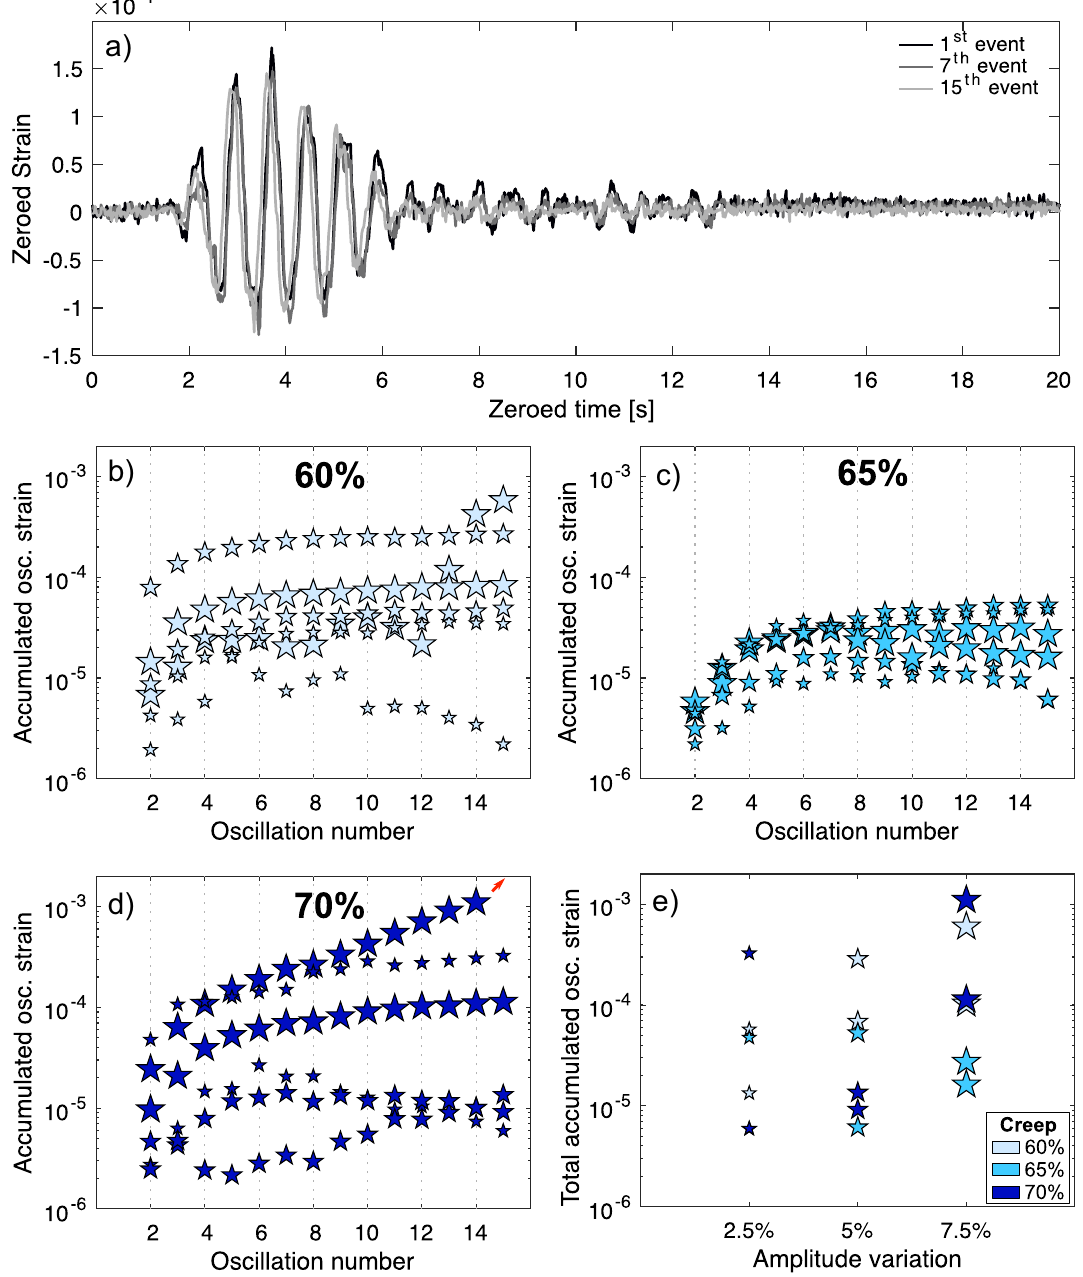
Figure 5. Inelastic strain accumulation caused by stress oscillations. ( a ) Strain response comparison between different stress oscillation events. Accumulated strain generated by the 15 stress oscillations during each of the tests at ( b ) 60%, ( c ) 65% and ( d ) 70% of the average uniaxial compressive strength (UCS); The red arrow indicates the trend followed by the sample that failed after 14 oscillation event. ( e ) Total accumulated inelastic strain after the final oscillation for all the creep conditions, plotted as a function of the amplitude of the stress oscillations. In ( b–e ) the different shades of blue correspond to different stress at each creep condition (the darker the shade, the higher the stress), and the size of the star depicts the amplitude of the stress oscillation (small stars correspond to ± 2.5%, intermediate to ± 5%, and large to ±